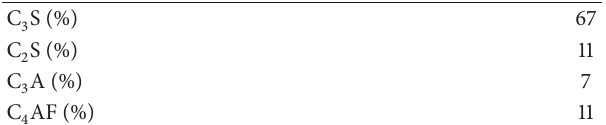
Table 3: Clinker’s composition